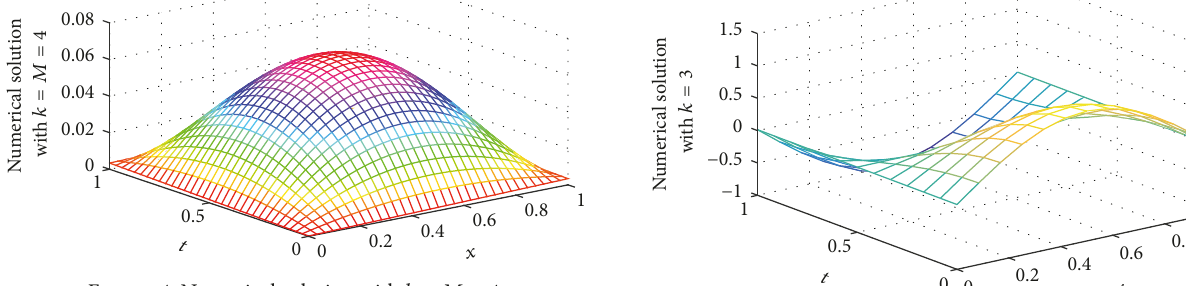
Figure 7: Numerical solution with 𝑘 = 3